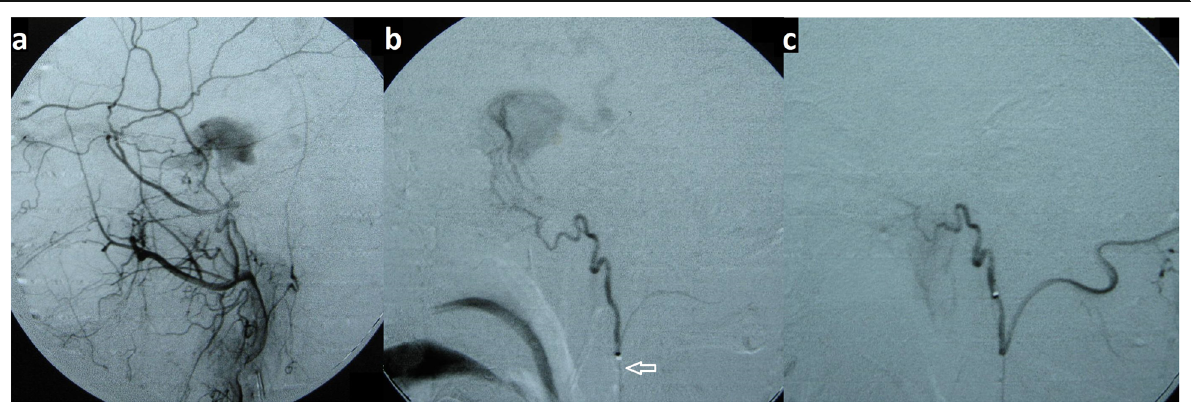
Fig. 2 a Right ECA DSA in lateral projection show type C indirect CCF with opacification of right cavernous sinus in arterial phase. b Selective cannulation of the feeding artery with microcatheter (arrow) for embolization with PVA particles. c Post embolization DSA shows non-filling of the fistula